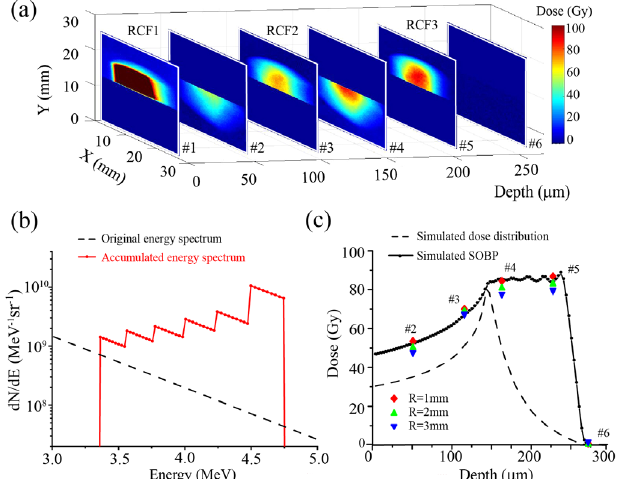
FIG. 7. Production of a spread-out Bragg peak with accumu- lated proton shots at different energies. (a) Dose distributions at different depths recorded on the RCF stack. The depth shift of the Bragg peak due to the aluminum foil is converted to an equivalent depth for the RCF film. Emulsion of the RCF layer is 8 μ m, and the thickness of RCF is measured as 111 μ m. (b) The black dashed curve is the exponentially decaying energy spectrum which is retrieved from the RCF records. The red curve is the total spectrum of proton beams accumulated to form the SOBP. (c) Comparison of experimental results with simulated depth profile. The black curve is the calculated accumulated dose distributions of all 203 shots of protons, as simulated using SRIM. The red, green, and blue dots represent the average doses within a 1, 2, and 3 mm radius of the beam center, respectively, at the different depths obtained in the experiment. The black dashed curve represents the expected dose profile if we use the exponentially decaying energy spectrum directly. The dose coordinate of the black dashed curve is magnified for ease of comparison, while the shape of the curve is not